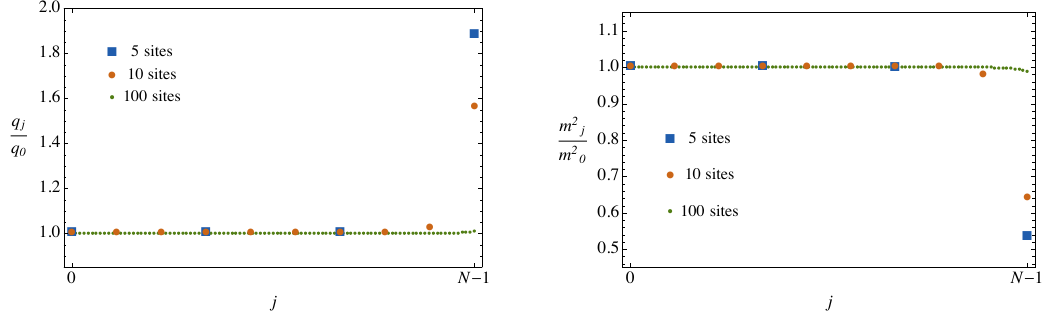
Figure 1 . Left: values of the charges q (cid:0) 1) that correspond j (normalized to q 0 , for j = 0 ; : : : ; N to a discrete clockwork mechanism arising from the deconstruction of a massive 5D scalar (cid:12)eld in q a (cid:13)at background, as described in section 5.1. For illustration, we choose M 2 (cid:25)R = 15, and focus (cid:30) on the case of N = 5 ; 10, and 100 lattice sites. We make the (cid:12)rst and last point coincident, so that the hierarchy between the (cid:12)rst and last charge parameters, and how it changes as we increase the number of sites, be compared between all three cases. Right: same as in the left (cid:12)gure but for the mass-squared clockwork parameters m 2 . j